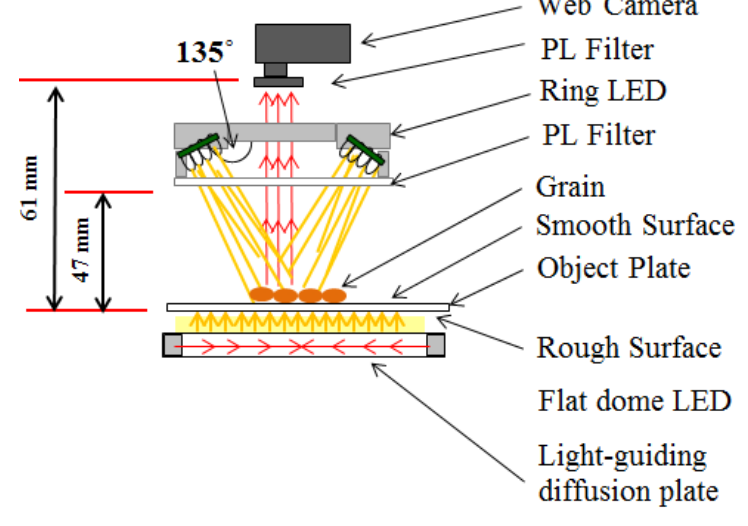
Figure 4. Layout of schematic diagram for double lighting